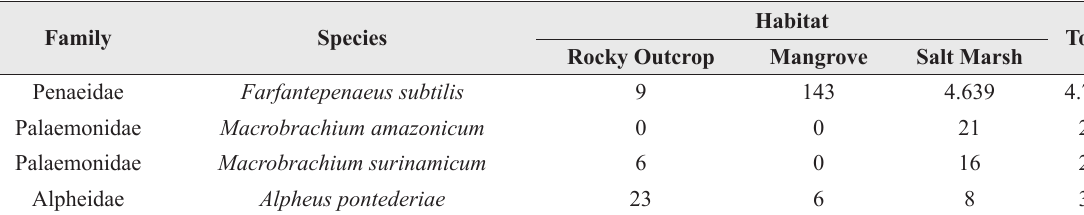
Composition of shrimp species on Areuá Beach, Guarás Island,